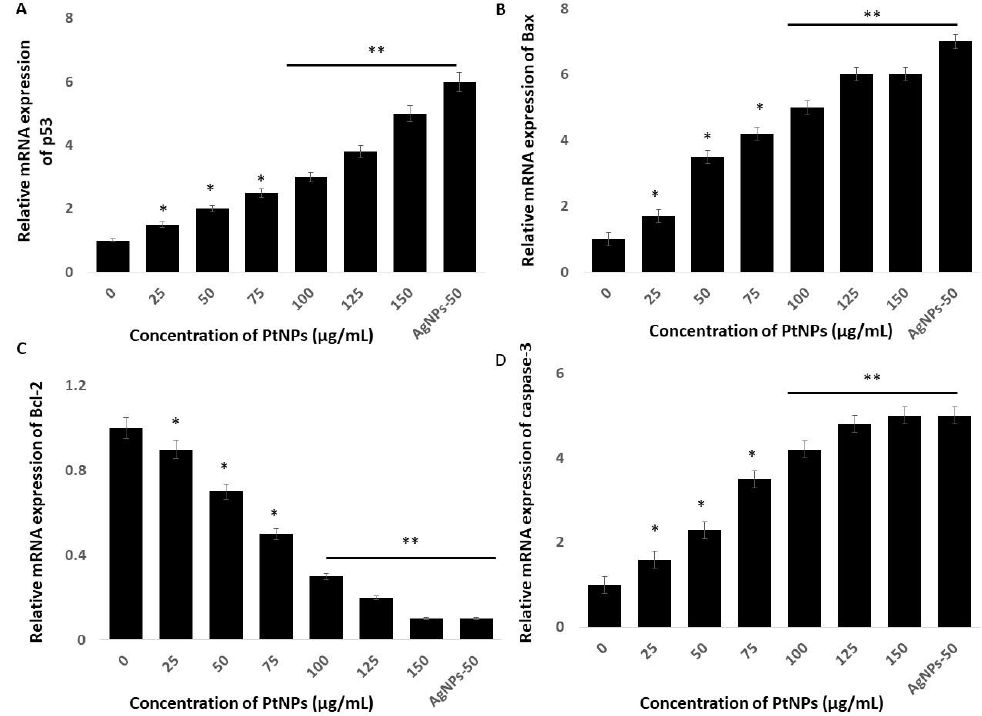
Figure 9. E ff ect of PtNPs on expression of pro- and anti-apoptotic genes. THP-1 cells were treated with various concentrations of PtNPs (25–150 µ g / mL) for 24 h. The mRNA expression of ( A ) p53, ( B ) Bax, ( C ) Bcl-2, and ( D ) caspase-3 genes was analyzed using quantitative reverse-transcription polymerase chain reaction in THP-1 cells treated for 24 h with PtNPs. After 24 h, the fold change in the expression was determined relative to GAPDH expression. All experiments were performed in triplicate, each being repeated at least three times. The treated groups showed statistically significant di ff erences from the control group by the Student’s t -test (* p < 0.05; ** p < 0.01). * significant; ** highly